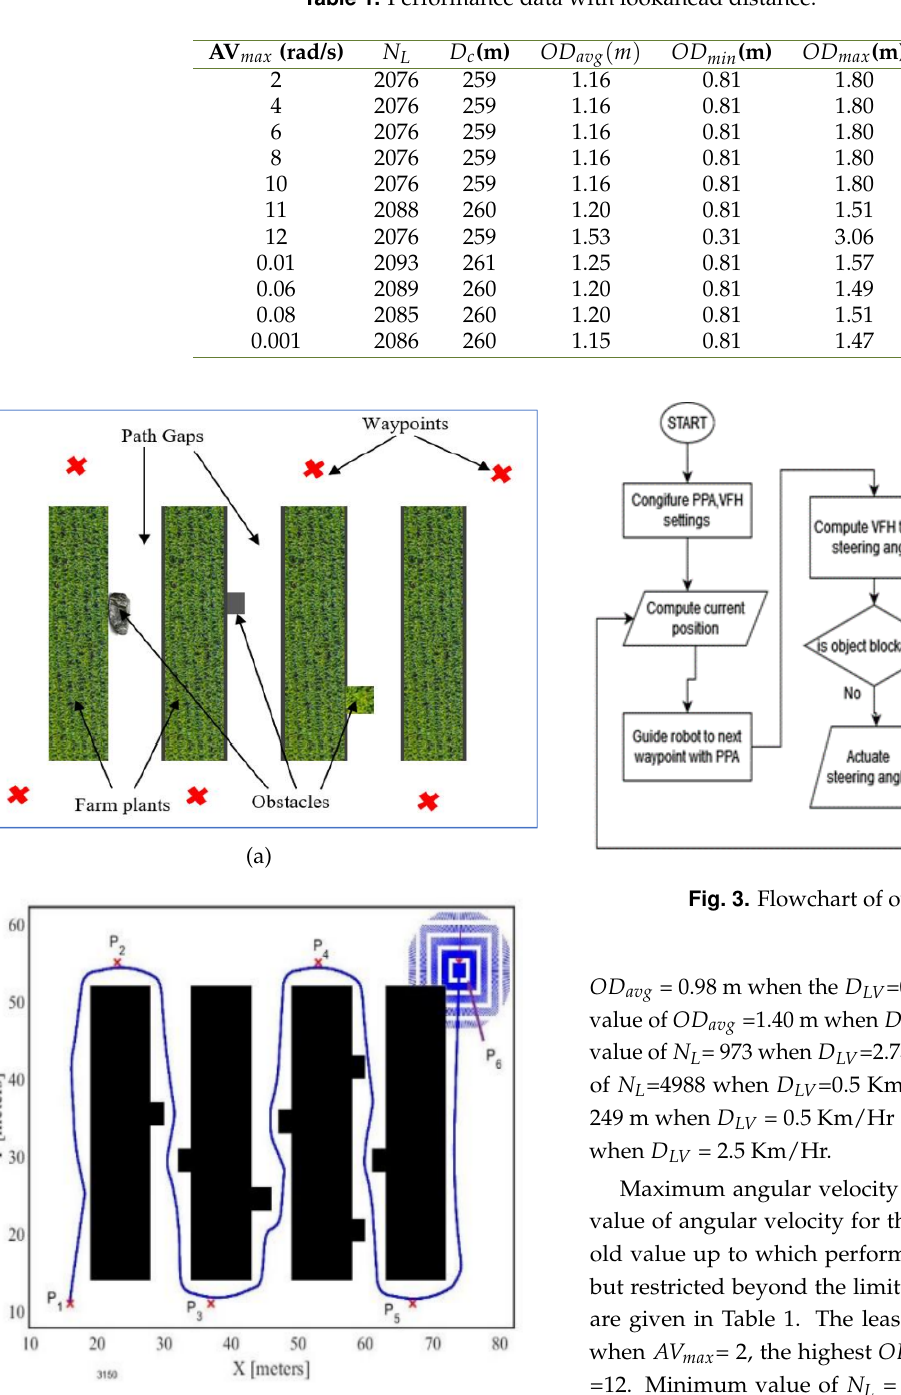
Table 1. Performance data with lookahead distance.